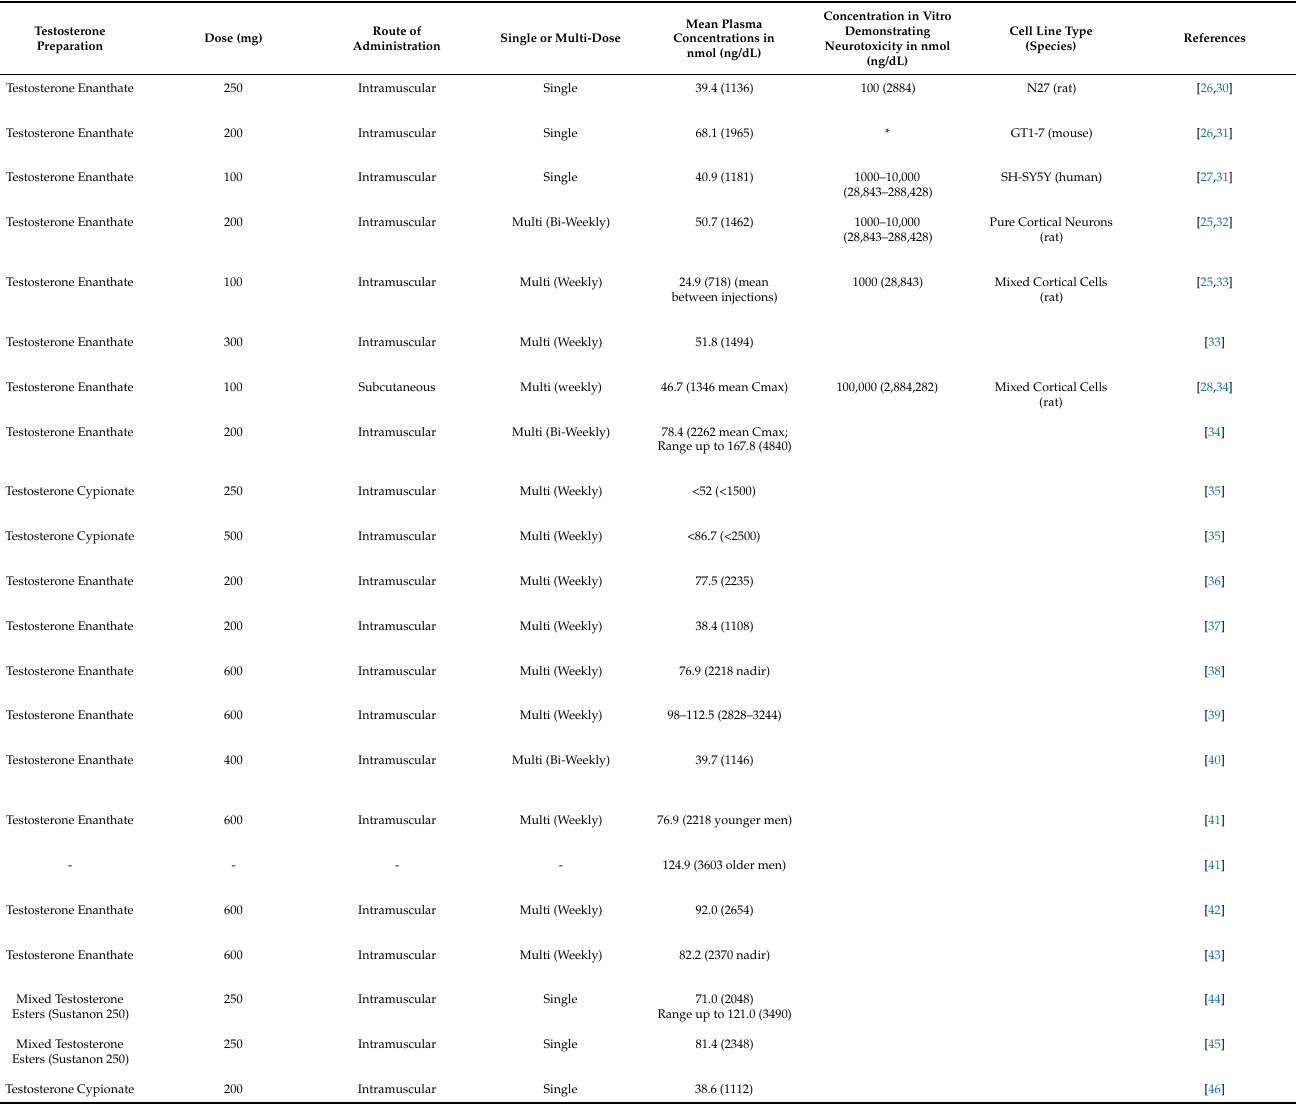
Table 1. Comparison of in vivo testosterone plasma concentrations with neurotoxic in vitro